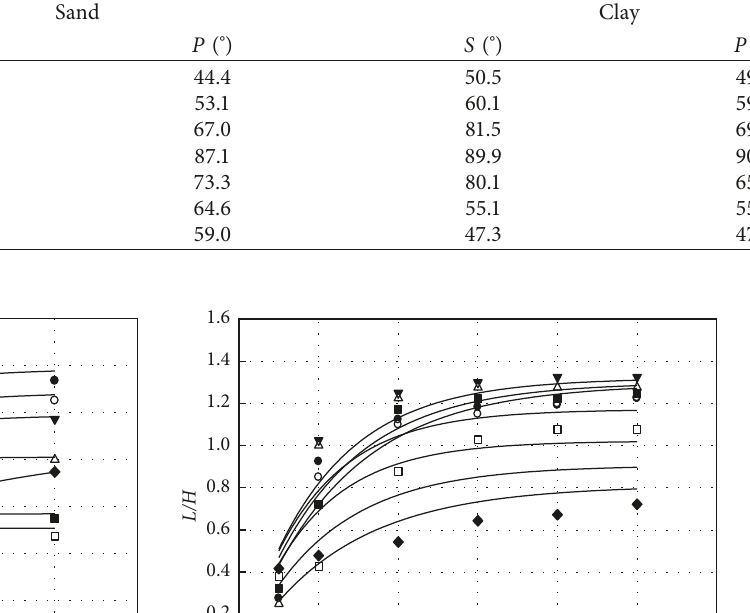
Table 2: Fracture zone inclination.